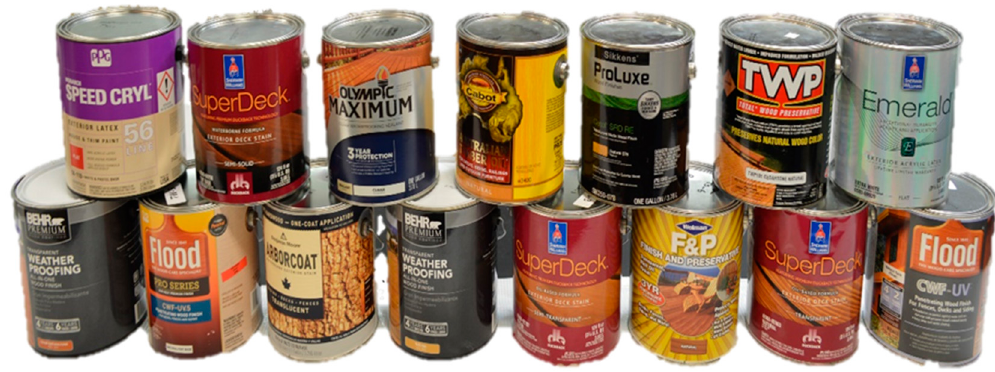
Figure 3. Some of the commercial coatings used in this study.